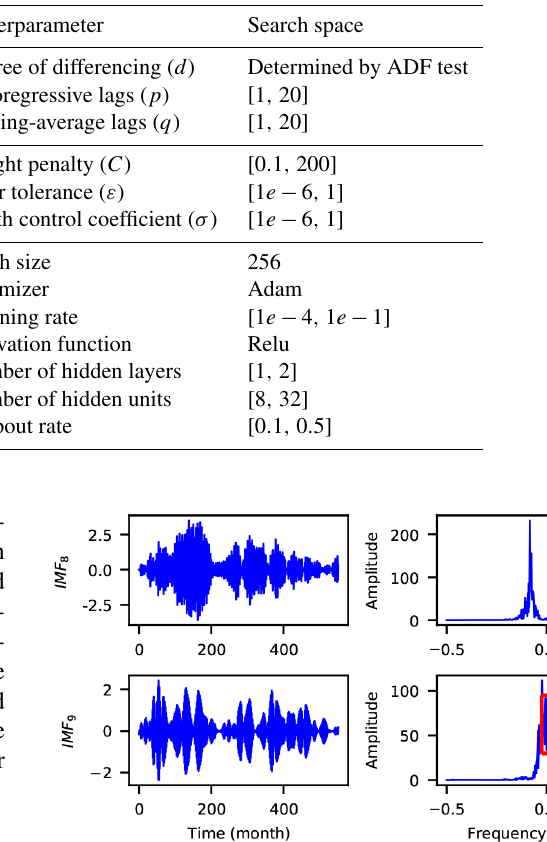
Figure 9. Center-frequency aliasing for the last signal component of time-series data collected from the Huaxian